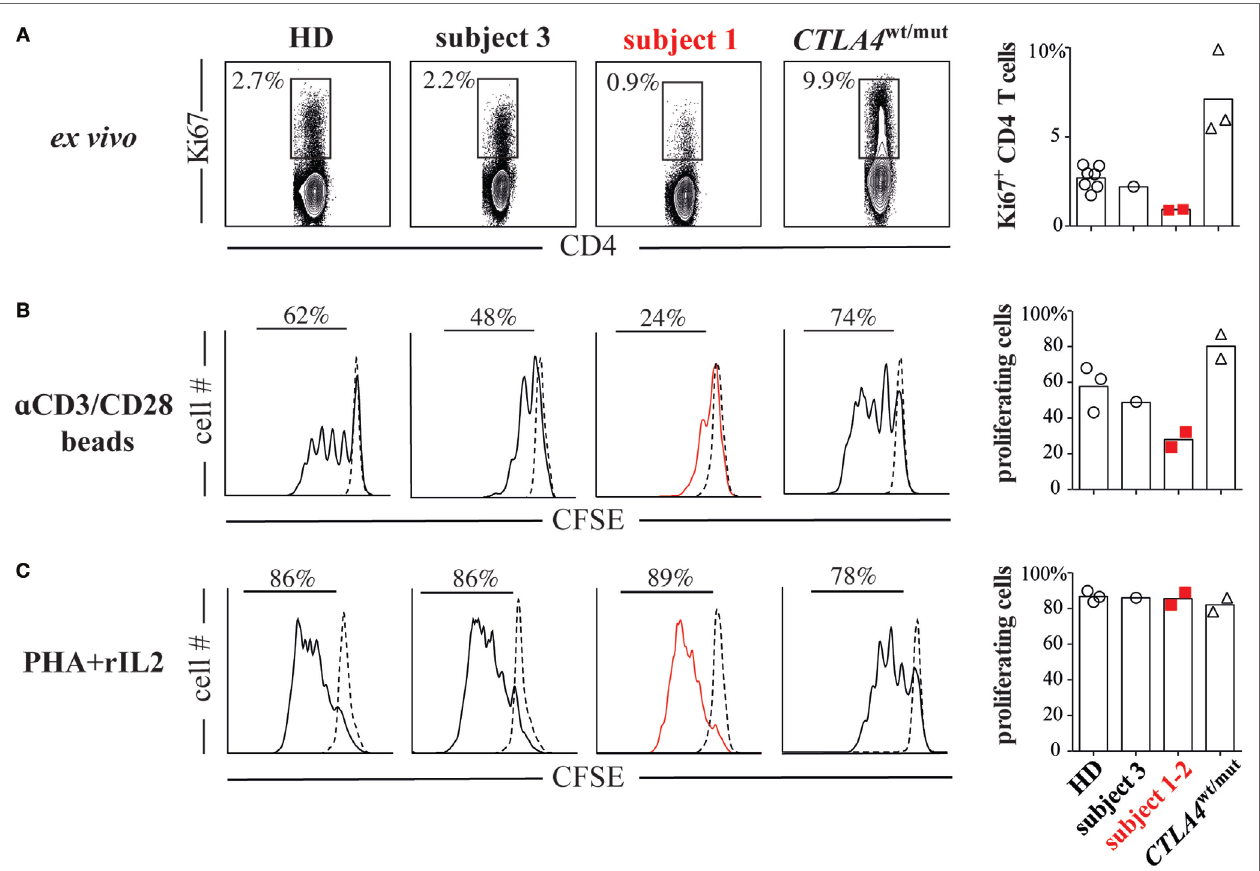
FIGURe 2 | CD28 haploinsufficiency is associated with T-cell hypoproliferation. (a) Subject 1/subject 2 display decreased frequencies of Ki67 + CD4 + T cells. (B) CFSE dilutions in sorted naïve T cells (CD4 + CD45RO − ) from subjects and healthy donor (HDs) cultured for 4 days with anti-CD2/CD3/CD28 coated beads or (C) phytohemagglutinin (PHA, 1 µg/ml) and recombinant interleukin 2 (rIL-2, 1 ng/ml) are